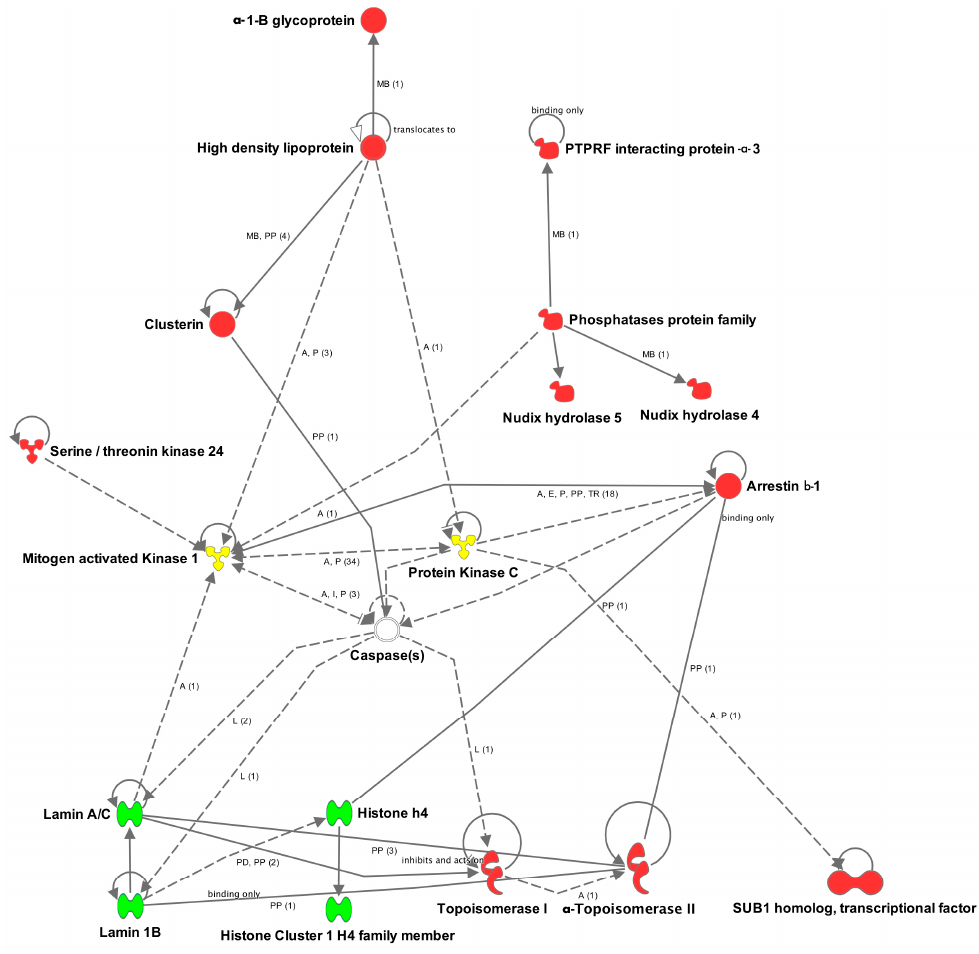
Figure 6. Ingenuity Pathway Analysis interactive protein network of highly up- or down-regulated retinal proteins. Up-regulated proteins (red) are located in the extracellular space, plasma membrane, cytoplasm, as well as in the nucleus. Down-regulated proteins in this network are exclusively located in the nucleus (green). The mitogen-activated protein kinase 1, protein kinase C (yellow) and caspase proteins show considerable interaction with a variety of displayed proteins with altered regulation levels. Legend: A = activation; L = proteolysis; P = phosphorylation/dephosphorylation; PP = protein–protein binding; I = inhibition; E = expression; PD = protein–DNA binding; TR = translocation; MB = group/complex membership; solid arrow = direct interaction; dashed arrow = indirect interaction; (count) = number of scientific references on the respective relation; if not indicated differently in the figure, the arrow head indicates “acts on”.